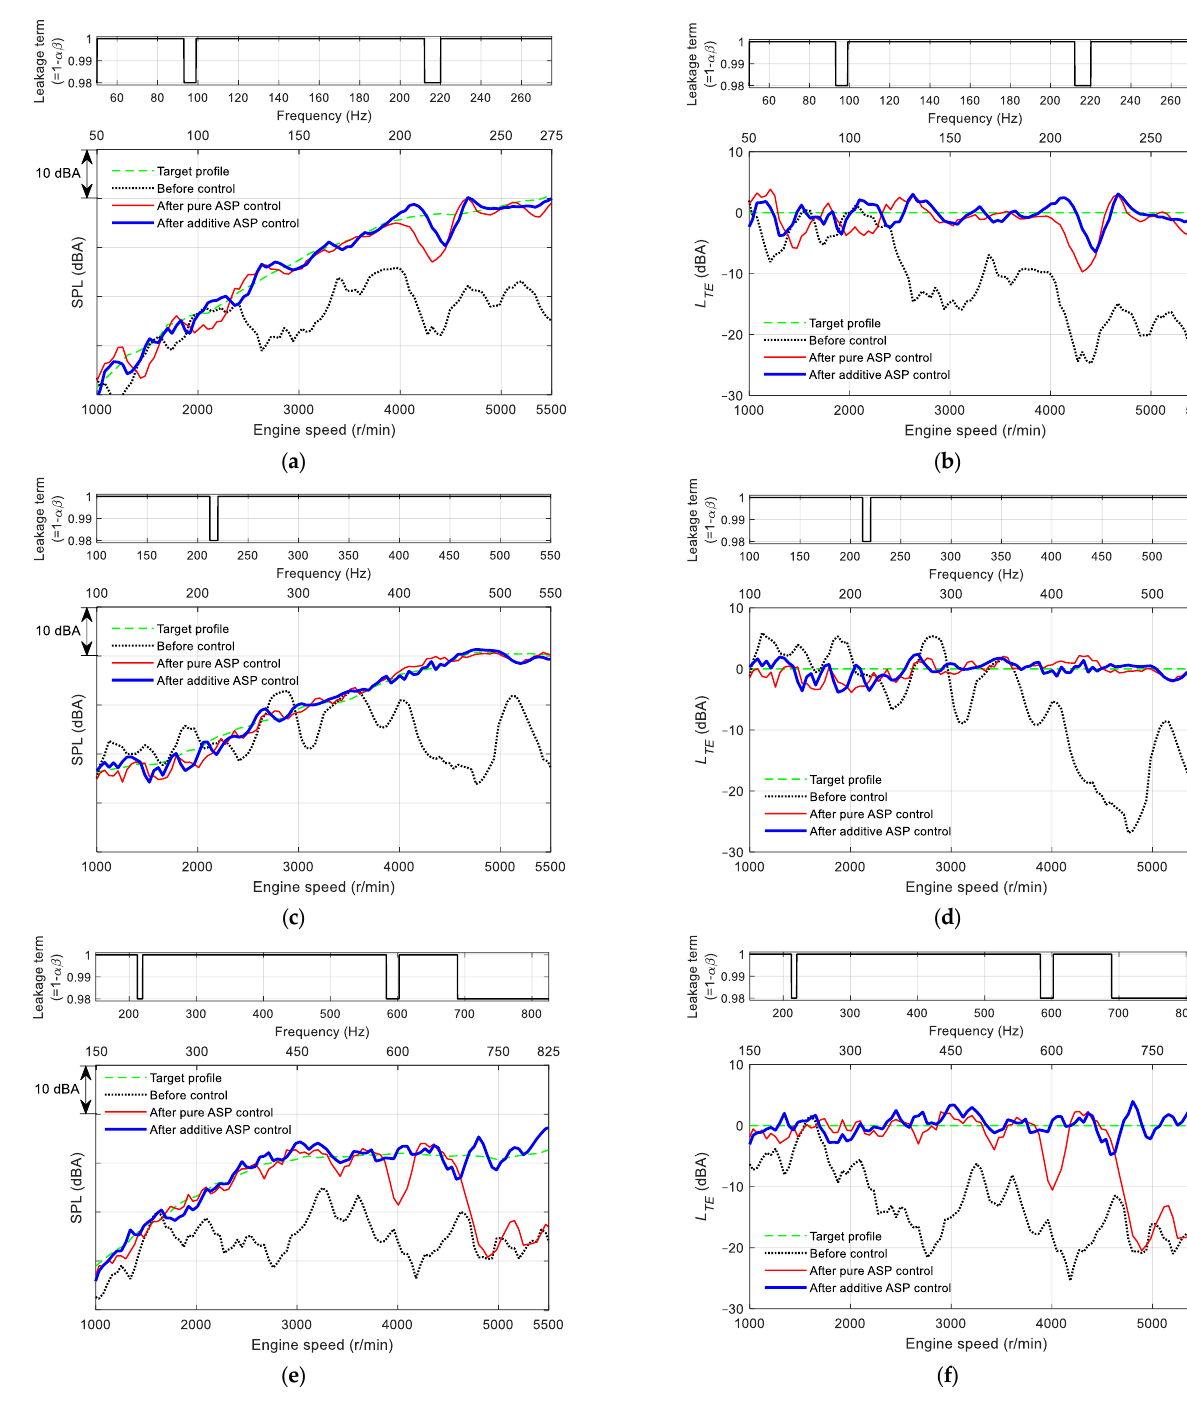
Figure 12. Comparisons of the measured SPL of each order after the pure and additive ASP controls, and the tracking errors between the measured SPLs and the target profiles. ( a ) SPL of the C3 order. ( b ) Tracking error of the C3 order. ( c ) SPL of the C6 order. ( d ) Tracking error of the C6 order. ( e ) SPL of the C9 order. ( f ) Tracking error of the C9 order.